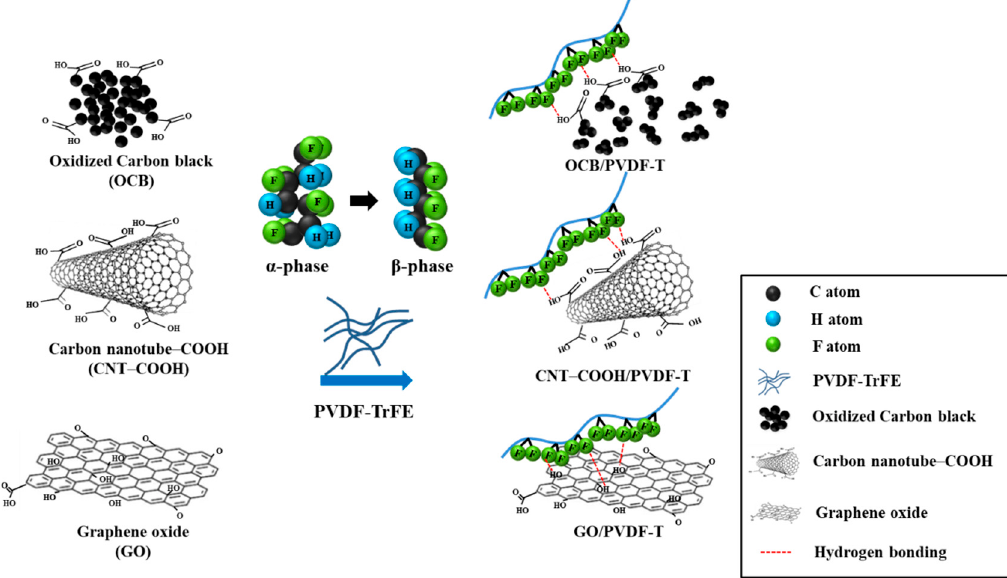
Figure 1. The schematic of carbon nanomaterials inducing the transformation of the α -phase to β -phase of PVDF-TrEE.